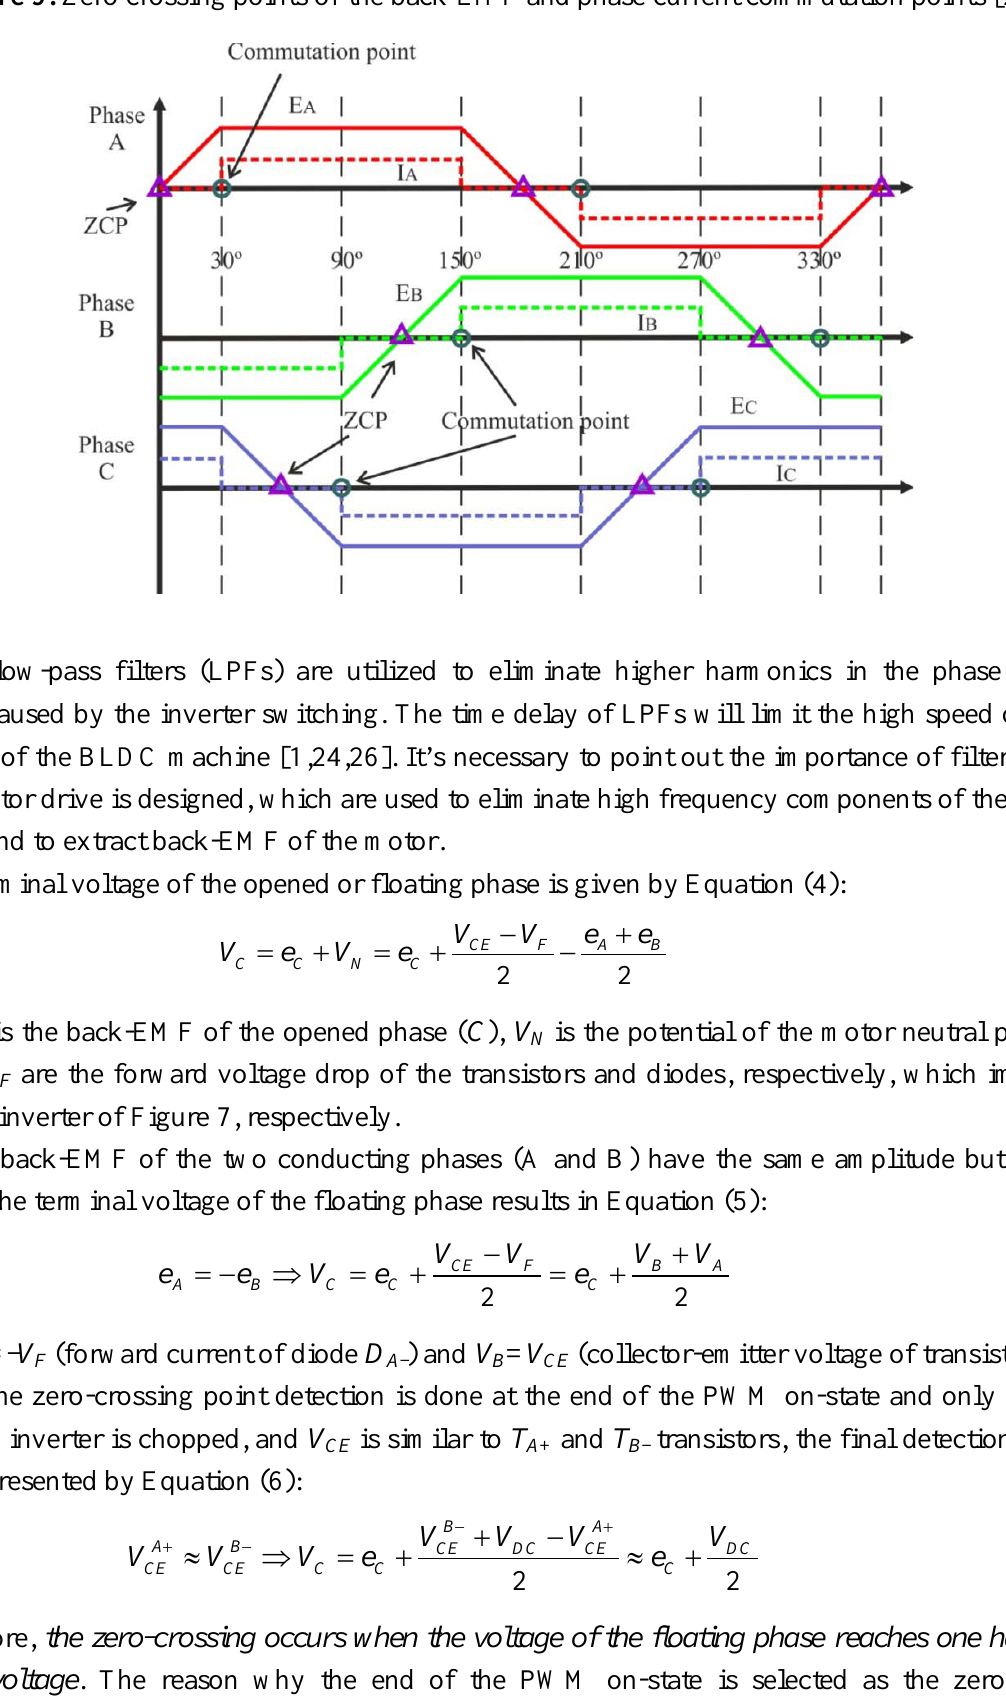
Figure 9. Zero crossing points of the back-EMF and phase current commutation points